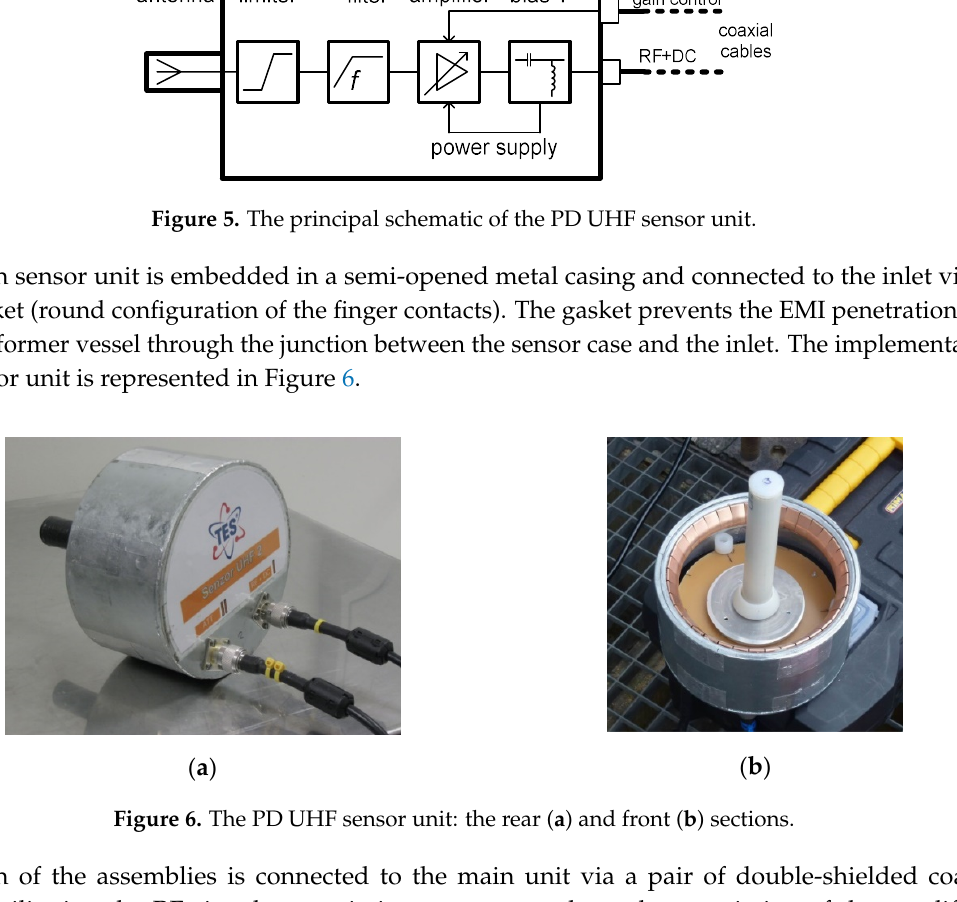
Figure 6. The PD UHF sensor unit: the rear ( a ) and front ( b ) sections.